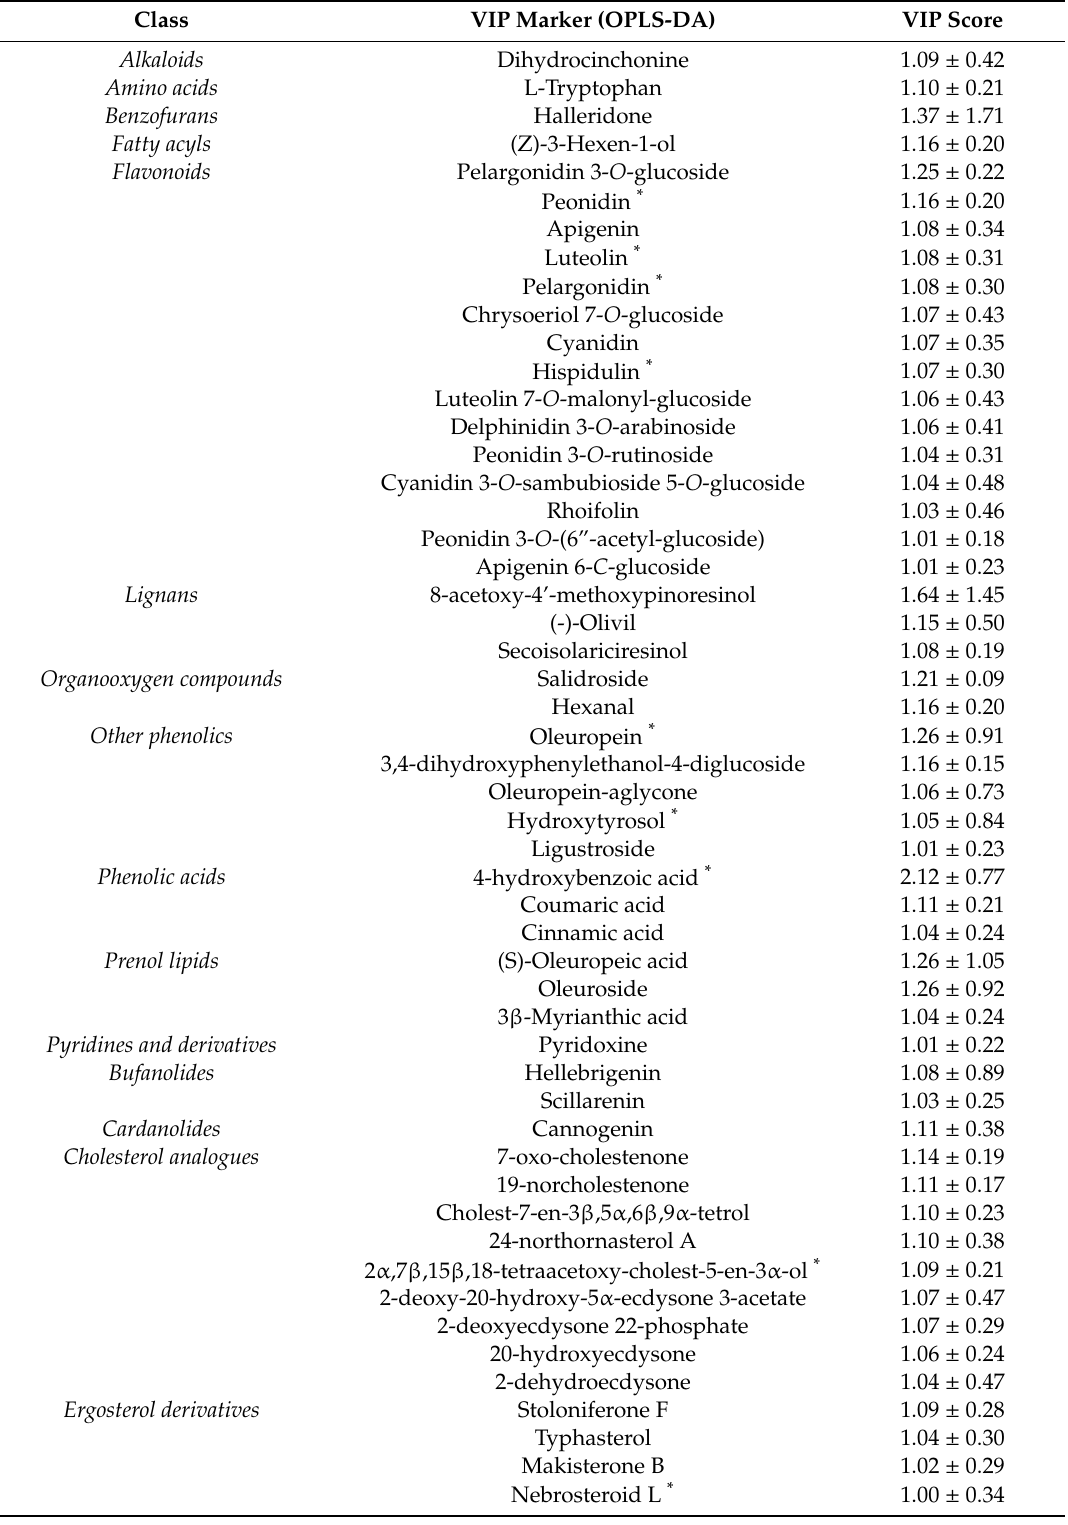
Table 1. VIP (variables importance in projection) markers following supervised OPLS-DA during in vitro gastrointestinal digestion of di ff erent EVOO samples. * = confirmed by naïve Bayesian